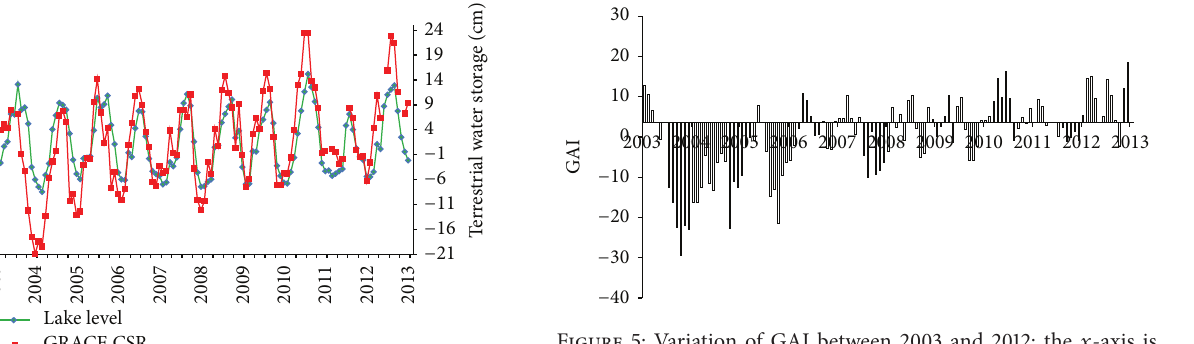
Figure 5: Variation of GAI between 2003 and 2012; the 𝑥 -axis is located at the mean of the GAI after